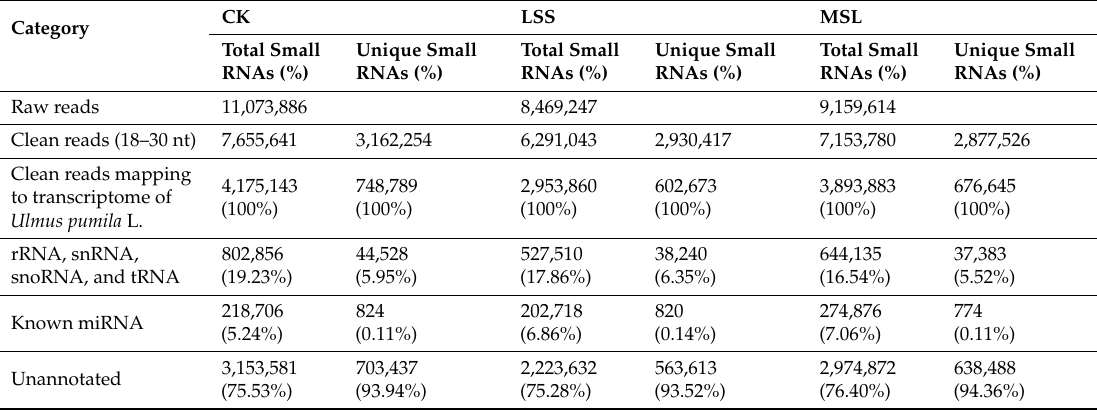
Table 2. Overview of small RNA reads from three small RNA libraries.